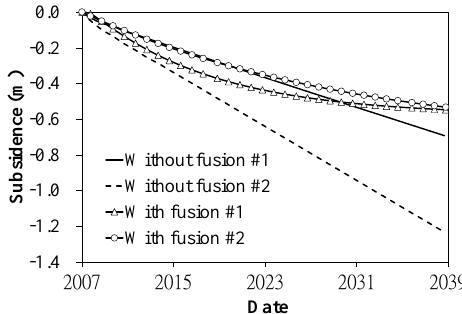
Figure 6. Comparison of results obtained with and without fusion for two leveling points marked in Fig. 5 (From Wang,